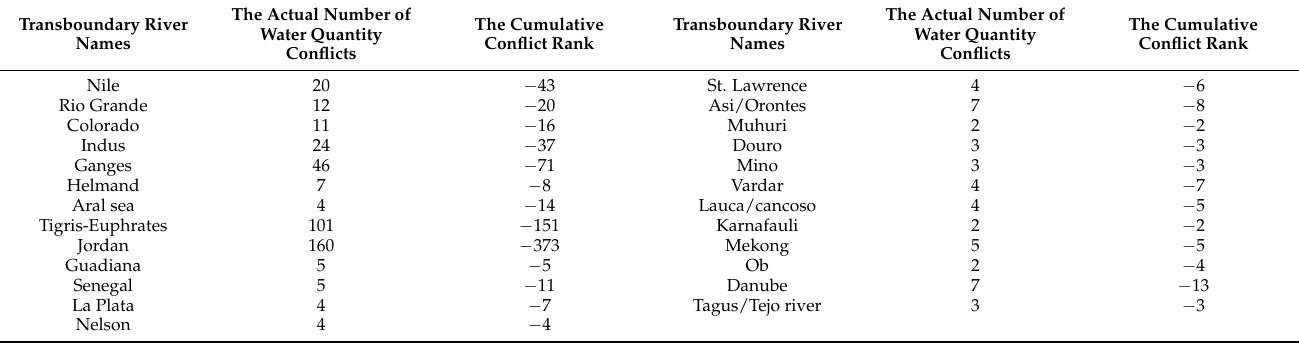
Table A2. The actual number and grade of water quantity conflicts in transboundary